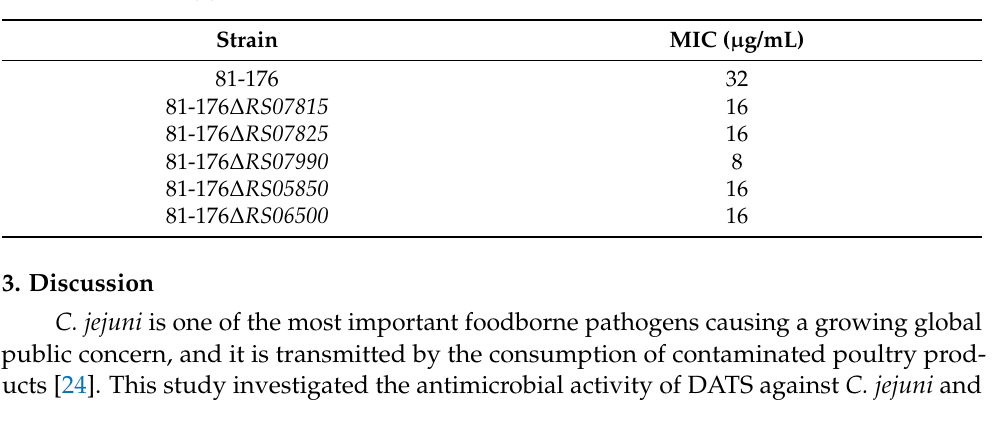
Table 3. MICs of C. jejuni 81-176 mutants in DATS.